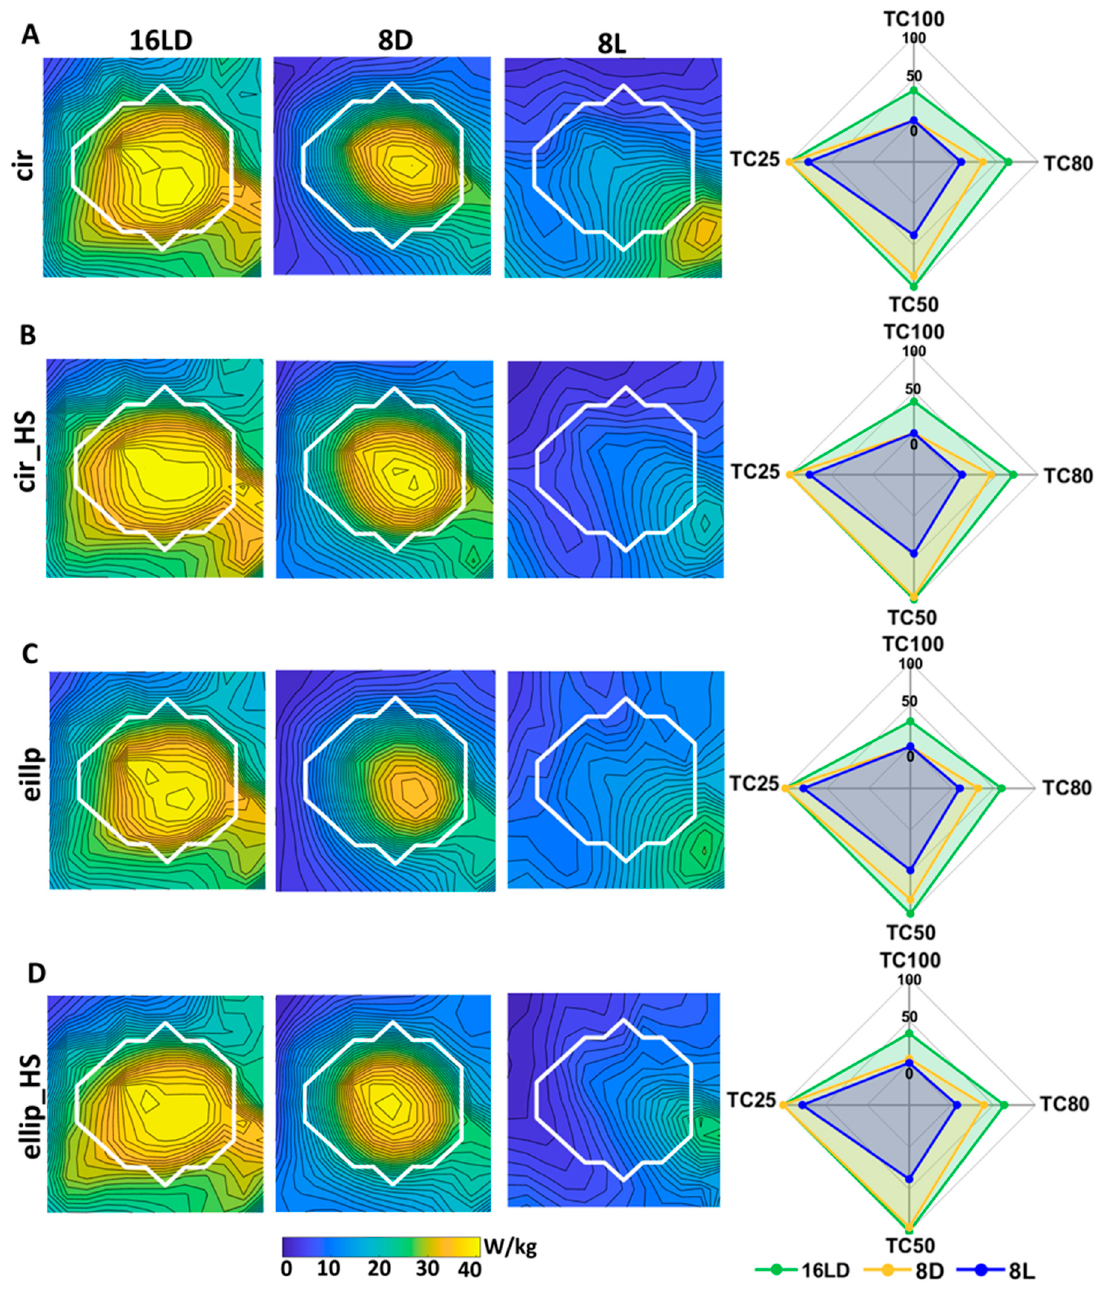
Figure 11. Magnified field of view (FoV) of RF power deposition (SAR 10g ) obtained from targeted RF heating optimization in the tumor target volume. The peak SAR 10g within the tumor TV (white line) is shown for 16LD, 8D, 8L ThermalMR RF applicators for the ( A ) cir, ( B ) cir_HS, ( C ) ellip, ( D ) ellip_HS variants. Quantification of tumor coverage (TC) is shown in the spider plots on the right, which show the fraction of the tumor enclosed within the 25, 50, 80 and 100% isolines of peak SAR 10g (TC25, TC50, TC80, TC100, respectively) for each ThermalMR RF applicator. The 16LD ThermalMR RF applicator achieved much greater TC50, TC80 and TC100 than the 8D. The 8L ThermalMR RF applicators failed to achieve TC25 = 100%, and in general had much lower TC values compared to 16LD and 8D ThermalMR RF